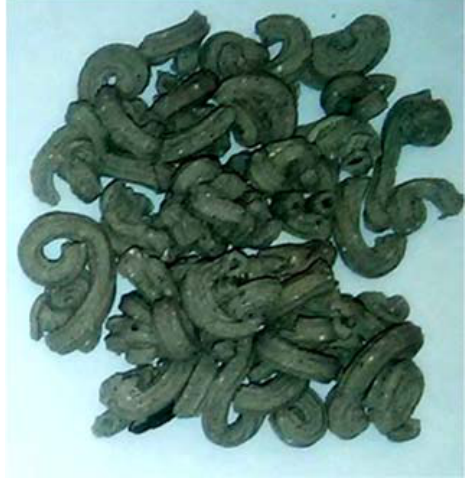
Figure 1. General view of the granular microbial preparation. Preparation of the granules of hydrogen-synthesizing microorganisms (GMP1) is described in our previous work [61]. The preparation procedure for this type of GMP was similar to GMP2. The main difference was drying in a ventilated laboratory electric furnace at 105 ◦ C after forming the granules. This temperature was used to destroy methanogens and select only spore-forming hydrogen-synthesizing